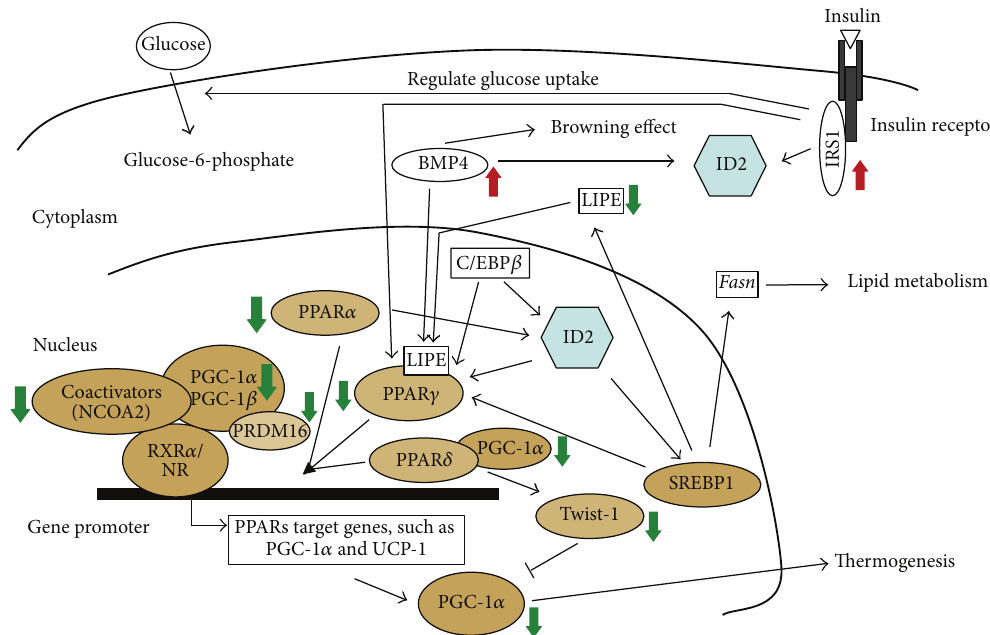
Figure 3: Id2 network model in insulin signaling, thermogenesis, and adipogenesis pathways. A schematized and partial view of the signaling pathway indicating its major downstream targets and factors susceptible to interfering with signaling. Function of ID2 is not necessarily limited to the nucleus [8]. ↑ or ↓ , up- or downregulation of gene expression, respectively, as determined by PCR array analysis in the current